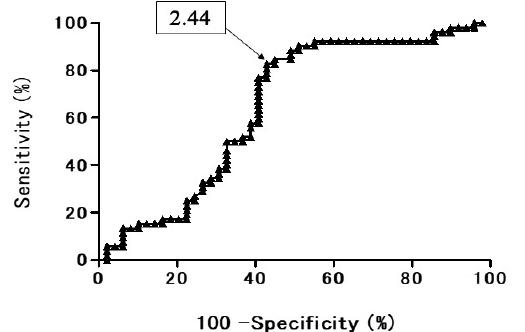
Figure 2. Receiver operating characteristic (ROC) curve presents the diagnostic performance of T2 CR for discriminating benign pulmonary nodule and mass (BPNM) from lung cancer. Area under the ROC curve (AUC) was 64.8% and the 95% confidence interval was 54.0% to 76.4%. T2 CR = 2.44, sensitivity 0.827 (43/52), specificity 0.596 (28/47), accuracy 0.717 (71/99), PPV 0.694 (43/62), and NPV 0.757 (28/37).